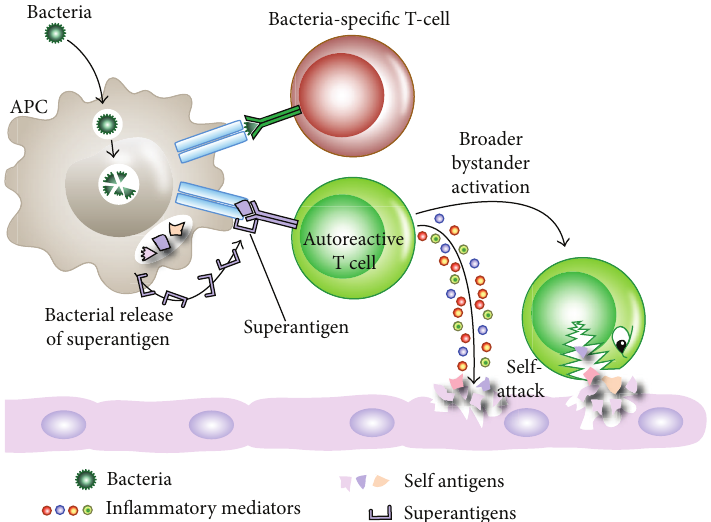
Figure 8: Superantigens and autoimmunity. Infection can lead to the release of superantigens, which can cross-link between MHCII and TCR, causing broader bystander activation, some of which may be specific for self-antigens, leading to attack on